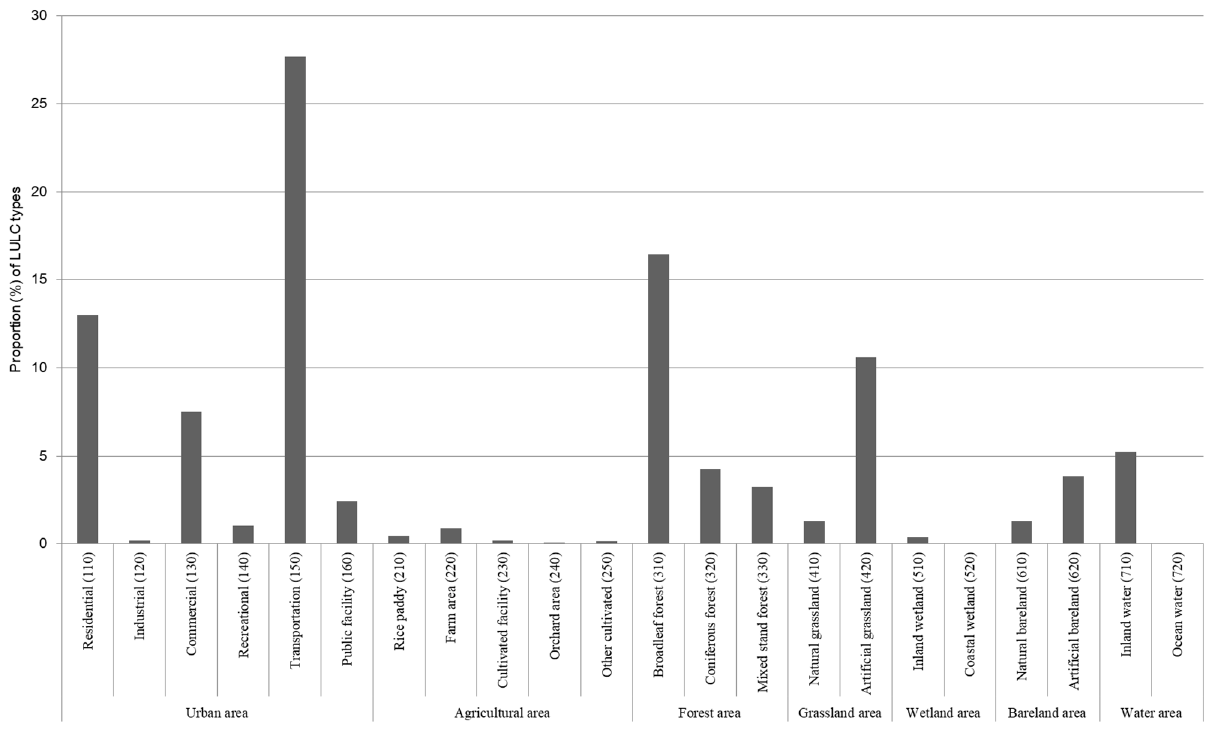
Figure 5. Proportion of LULC types in Seoul.